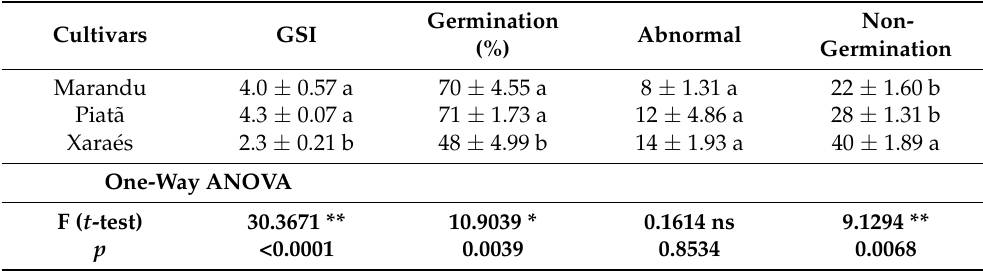
Table 2. Germination speed index (GSI), germination percentage (%), normal, abnormal, and non- germinated seedlings of the three investigated Brachiaria cultivars after 13 days of